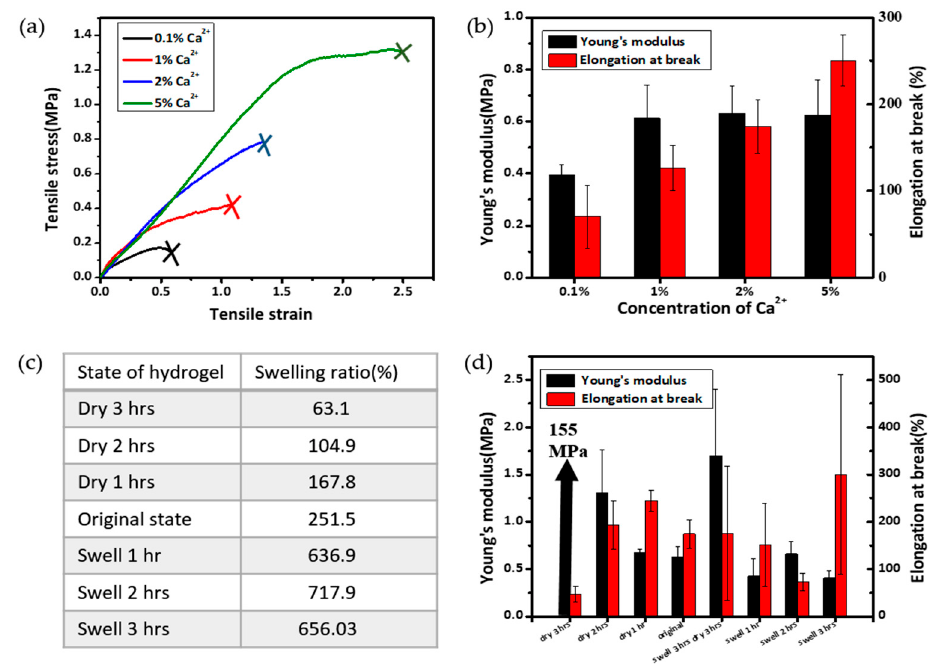
Figure 4. Investigation of the mechanical properties as a function of Ca 2+ concentrations ( a , b ) and time-dependant swelling/drying conditions ( c , d ). ( a ) Tensile stress-strain curves and ( b ) Young’s modulus and elongation at break values with various calcium concentrations; ( c ) swelling ratio and ( d ) Young’s modulus and elongation at break values at various time-dependant swelling/drying conditions. All hydrogels have the MBAA concentration of 0.10%. The original state refers to the synthesis condition that hydrogel was vacuum dried in the oven for 2 h at 65 °C after dialysis of three days.